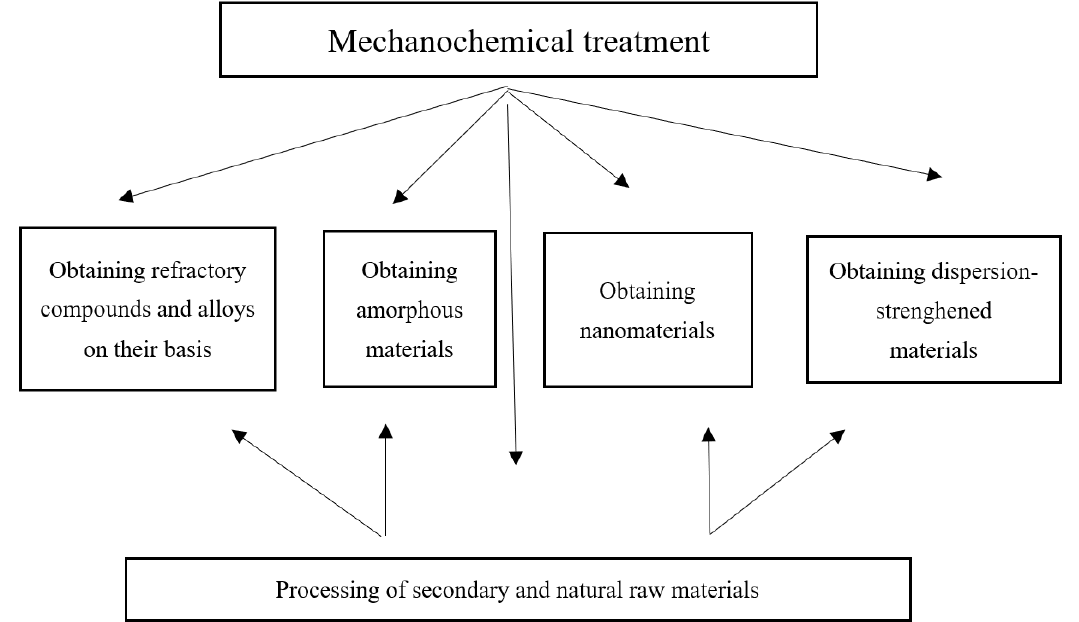
Figure 1. Application of mechanochemical technology in modern materials science [10].